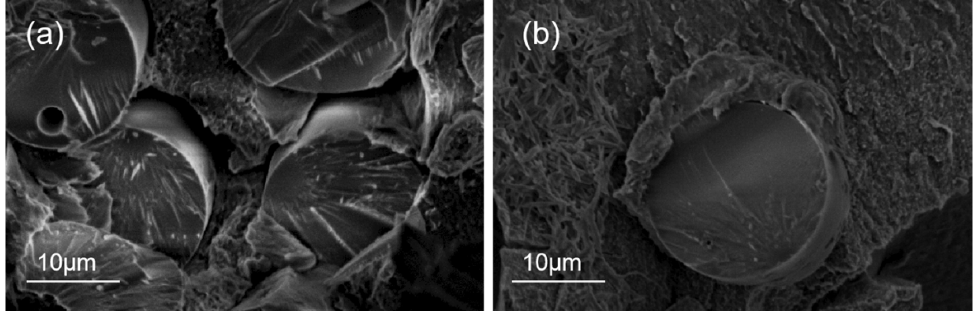
Figure 8. SEM cross-sectional photos of composites before and after treatment with silane coupling agent ( a ) pre-modified SEM ( b ) modified SEM.